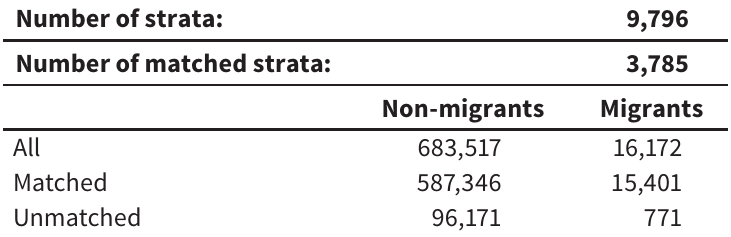
Matching summary